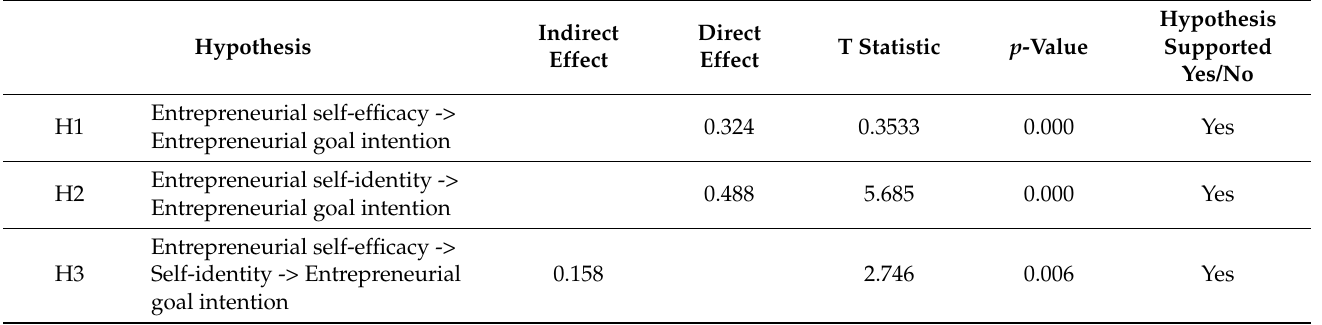
Table 5. Hypothesis